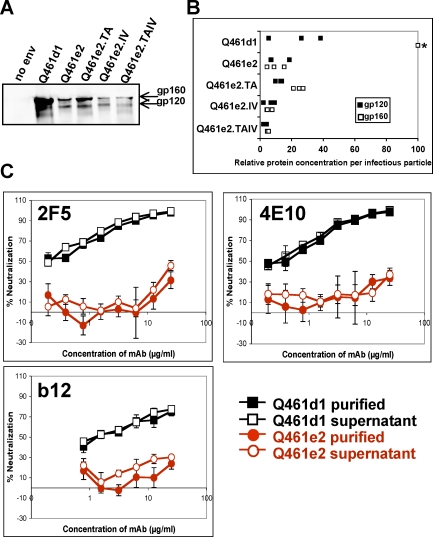
Evaluation of HIV-1 Envelope Concentration and Dissociation of Q461 Envelope Variants(A) A Western blot of purified viral variants is shown. The viral variant tested is indicated along the top; an equal number of infectious particles was loaded for each viral variant. The “No env” negative control was prepared from cell-free viral supernatant produced from Q23Δenv in the absence of a plasmid encoding a viral Env; because this preparation was unable to infect cells, the maximum possible volume was subjected to purification. The gp160 and gp120 bands are marked with an arrow.(B) Relative gp160 and gp120 expression levels calculated from Western blotting are shown for each of three triplicate experiments. The pseudovirus is indicated on the left, gp120 is shown in the black symbols, and gp160 in the open symbols. Levels of protein expression were normalized relative to the gp160 from Q461d1, which was assigned the level of 100, and marked with an asterisk. The Spearman rank test revealed no correlation between either gp120 or gp160 concentration and susceptibility to any MAb or plasma sample (p > 0.8 for all comparisons).(C) Neutralization curves of purified (closed symbols) and unpurified viral supernatant (open symbols). Results are shown for both Q461d1 (black squares) and Q461e2 (red circles) with 2F5, 4E10, and b12. As in Figure 1B, the y-axis represents the percentage of neutralization, the x-axis represents the concentration of MAb, and the antibody tested is indicated in the inset.